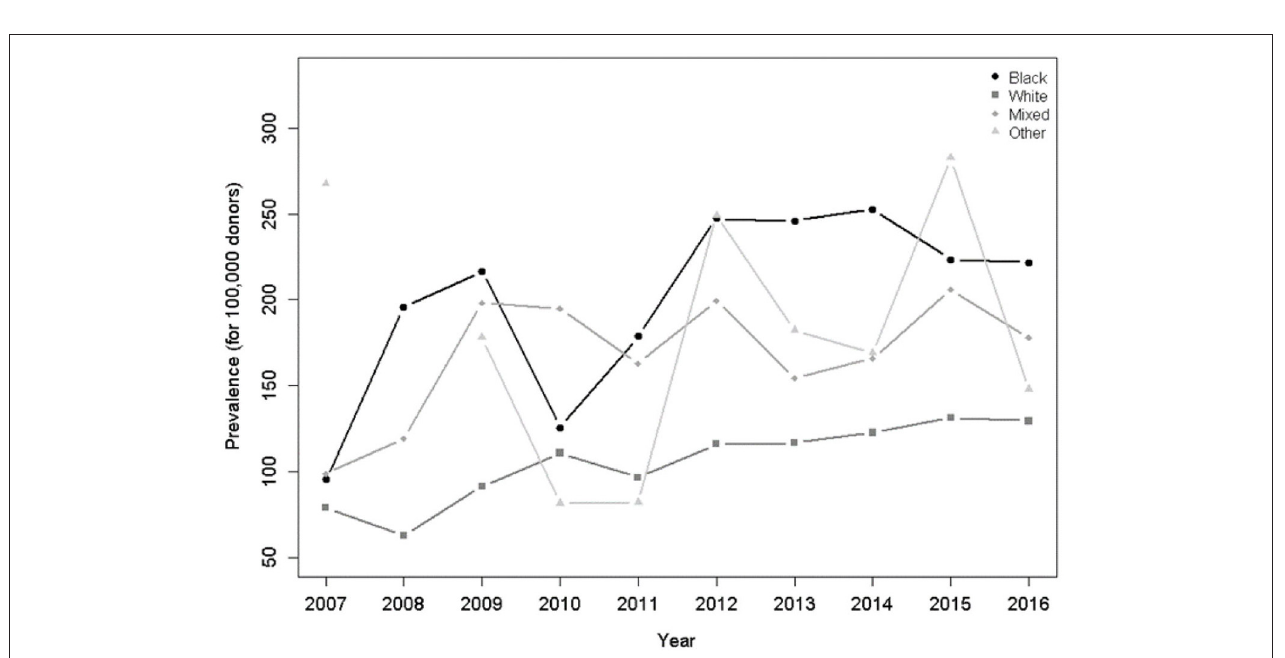
seroprevalence study in blood centers, but done without the use of confirmatory testing and based on an EIA (4). Based on data of all the Brazilian States and the Federal District, the prevalence per 100,000 blood donors was 750 in Recife, 470 in